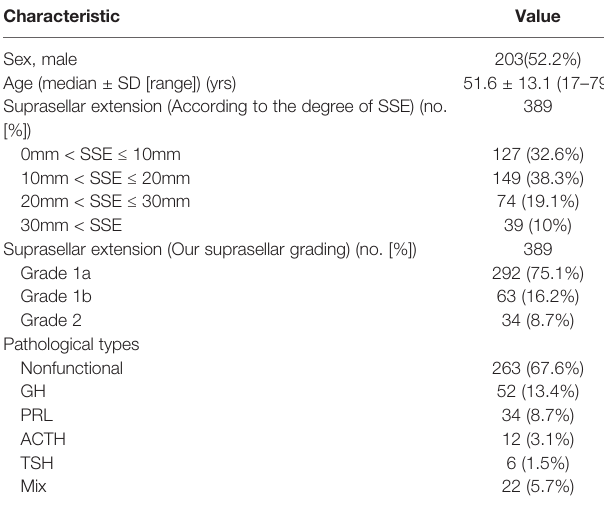
FIGURE 2 | (A) Illustration demonstrating the “ two points and one line ” method. (B, C) Receiver operating characteristic (ROC) curves for evaluating the predictive power of the SSE (B) and H1 (C) for the expand endoscopic endonasal approach. (D) The vertical height (H1) from the upper surface of the tumor to the AB line is within 8.1 mm and often a standard endoscopic endonasal approach can remove the tumor. (E) Tumors that exceed the AB line by 8.1 mm often require an extended endoscopic endonasal approach. Point A, the inferior border of the nostril. Point B, the inferior border of the tuberculum sellae. Point C, the inferior border of the optic chiasm. H1, the vertical height from the upper surface of the tumor to the AB TABLE 1 | Patient and tumor characteristics.